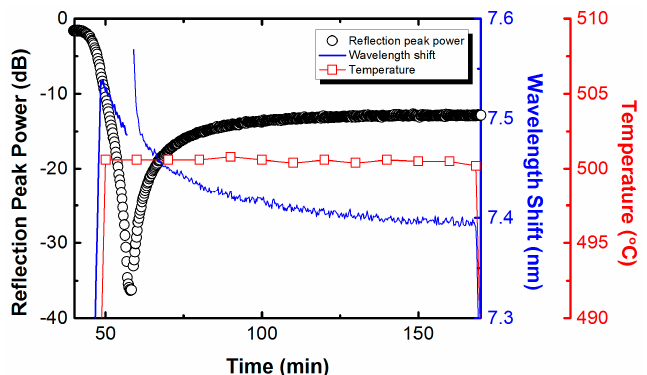
Figure 6. Evolution of the reflection peak power and the Bragg wavelength shift of the grating shown in Figure 1 during the isothermal annealing at 500 °C. in Figure 1 during the isothermal annealing at 500 ◦